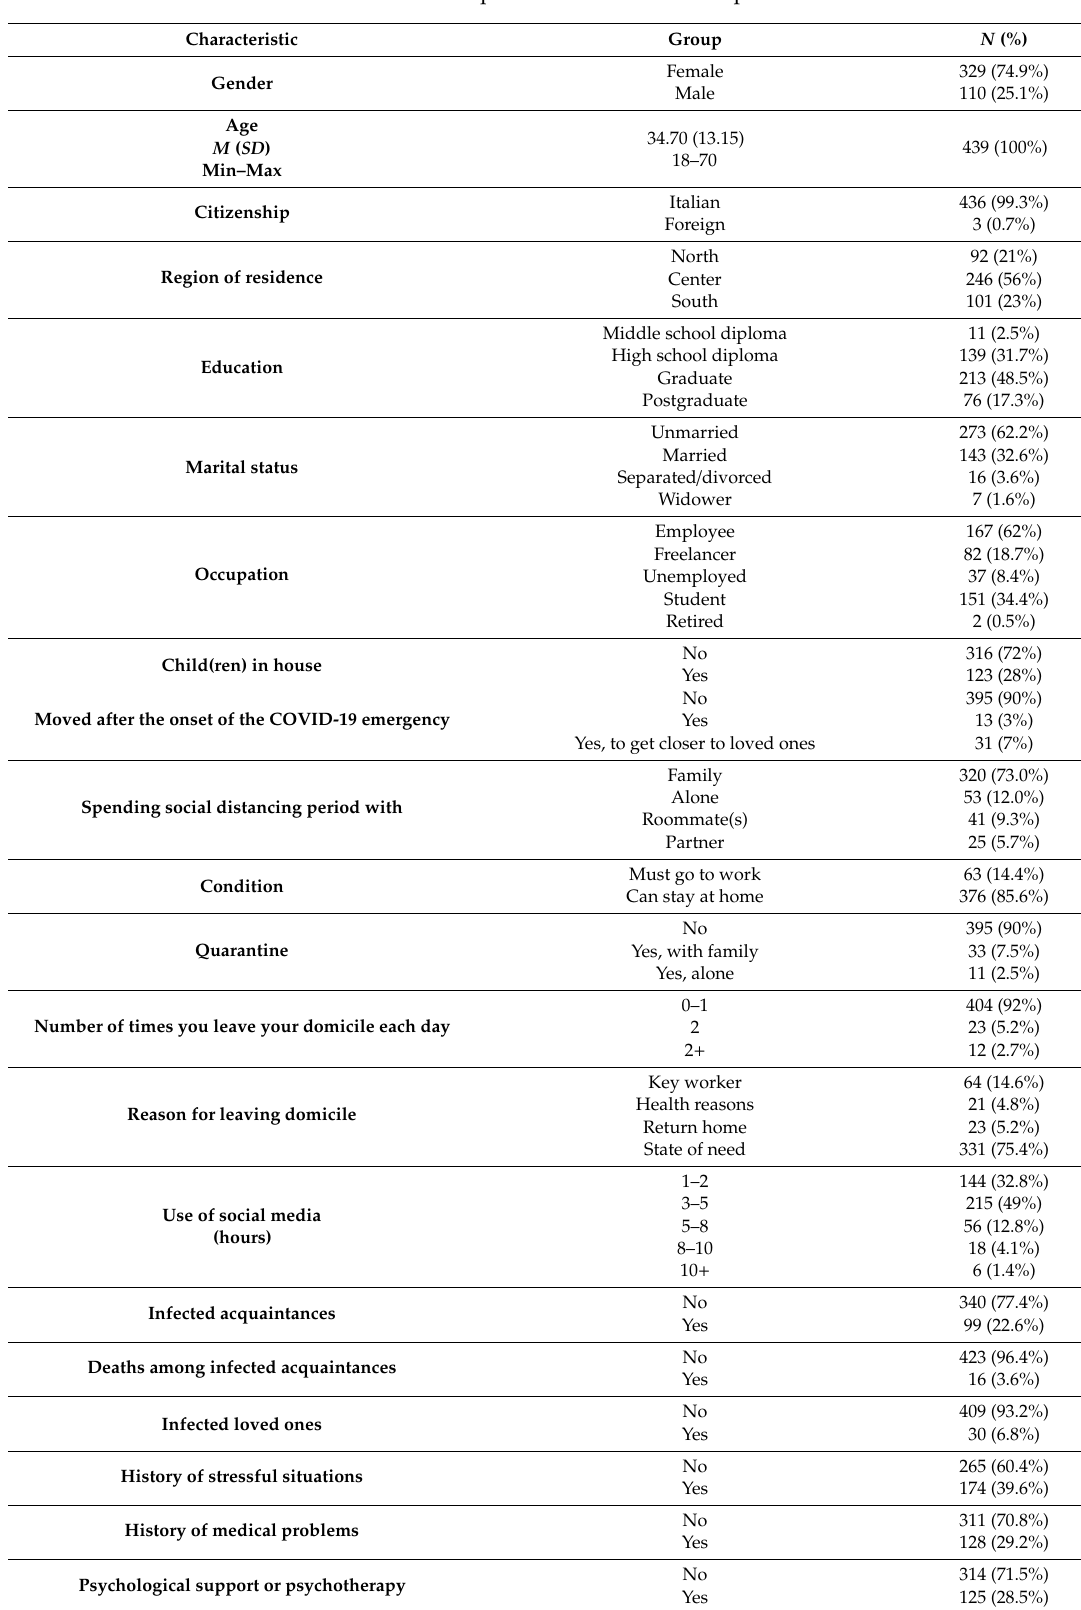
Table 1. Descriptive Statistics of the